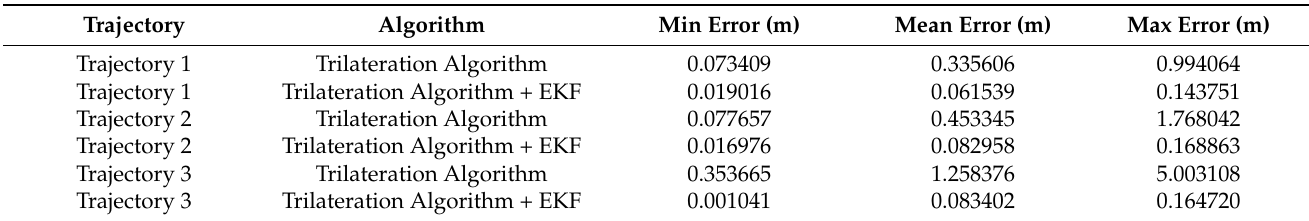
Figure 5. Position Estimation in Path 3 Trilateration Algorithm with and without EKF. Table 2. Error Comparison Table.